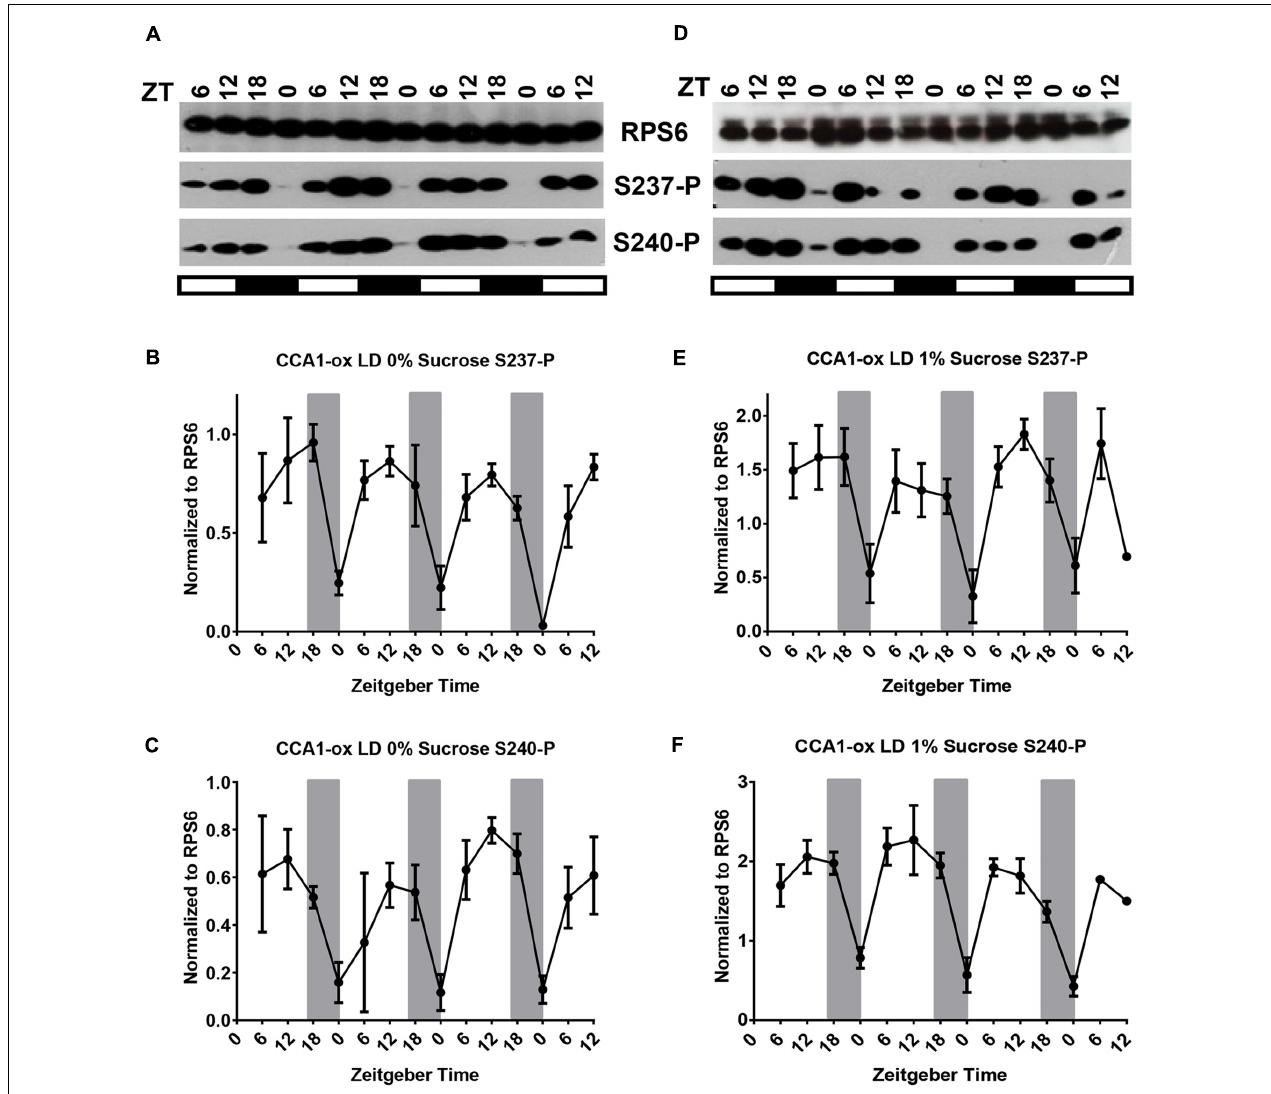
FIGURE 2 | A long-day light-dark cycle drives cycles of RPS6 phosphorylation with a peak during the day. 12-day-old seedlings of Arabidopsis clock-deficient plants (CCA1-ox) were scored for phosphorylation of RPS6 (ribosomal protein eS6) every 6 h for another three and a half days. Seedlings were grown in a long-day light-dark cycle on medium lacking sucrose (A–C) or containing 1% sucrose (D–F) . (A,D) Representative immunoblots for S237-P and S240-P. (B,C,E,F) Immunoblot signals for S237-P and S240-P were quantified and normalized against total RPS6 signals from the same time point. Error bars show the standard error of the mean from n = 2 replicates for 0% sucrose and n = 3 for 1% sucrose, grown at different times, which were immunoblotted once or twice each. For details see legend to Figure 1